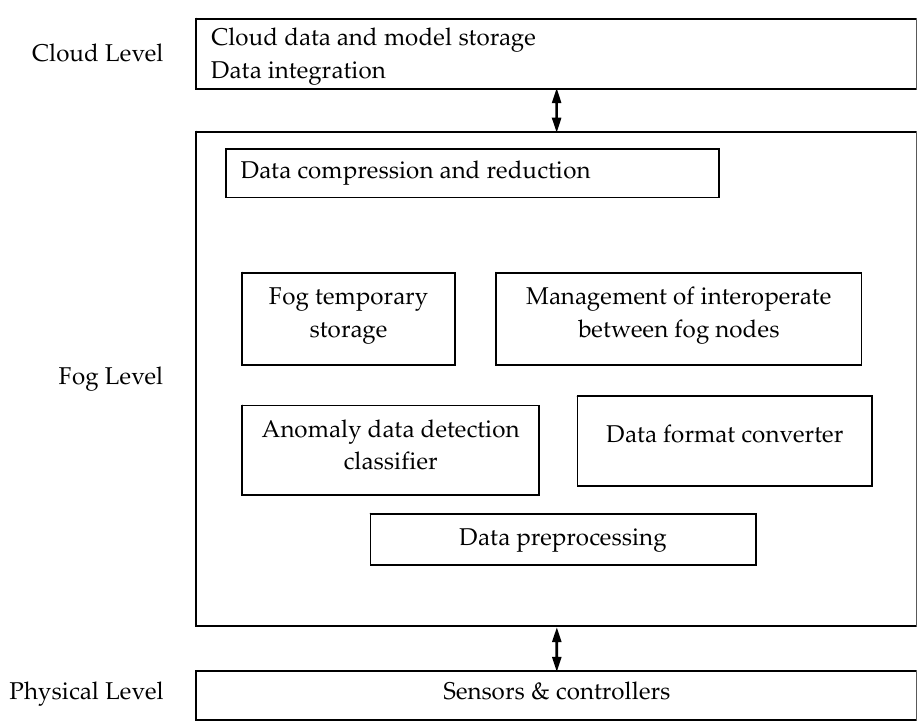
Figure 6. DC method at the fog level.